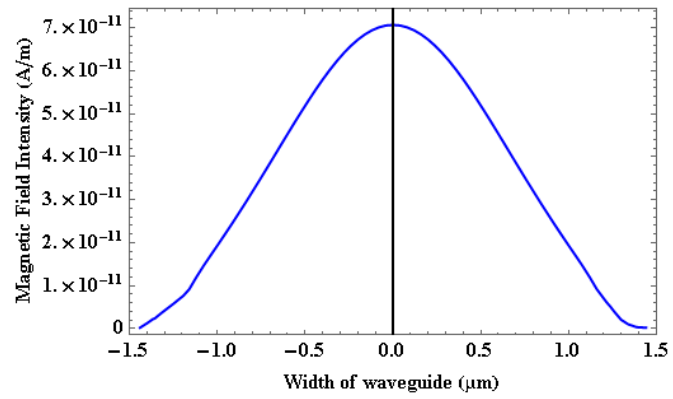
Figure 8. Magnetic field intensity as a function of width of waveguide.